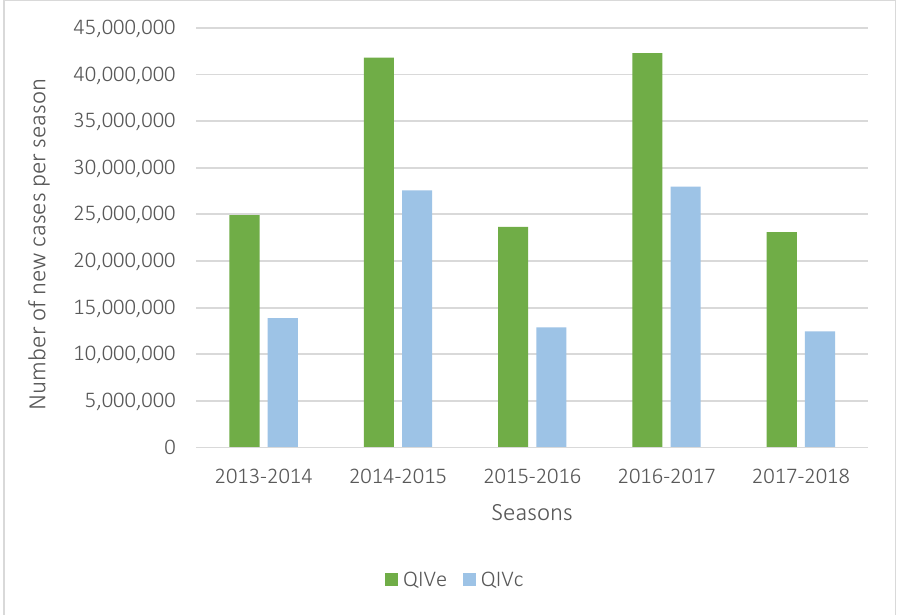
Figure 2. Number of influenza cases in the overall US population over the 5 studied seasons considering systematic A(H3N2) mismatch.